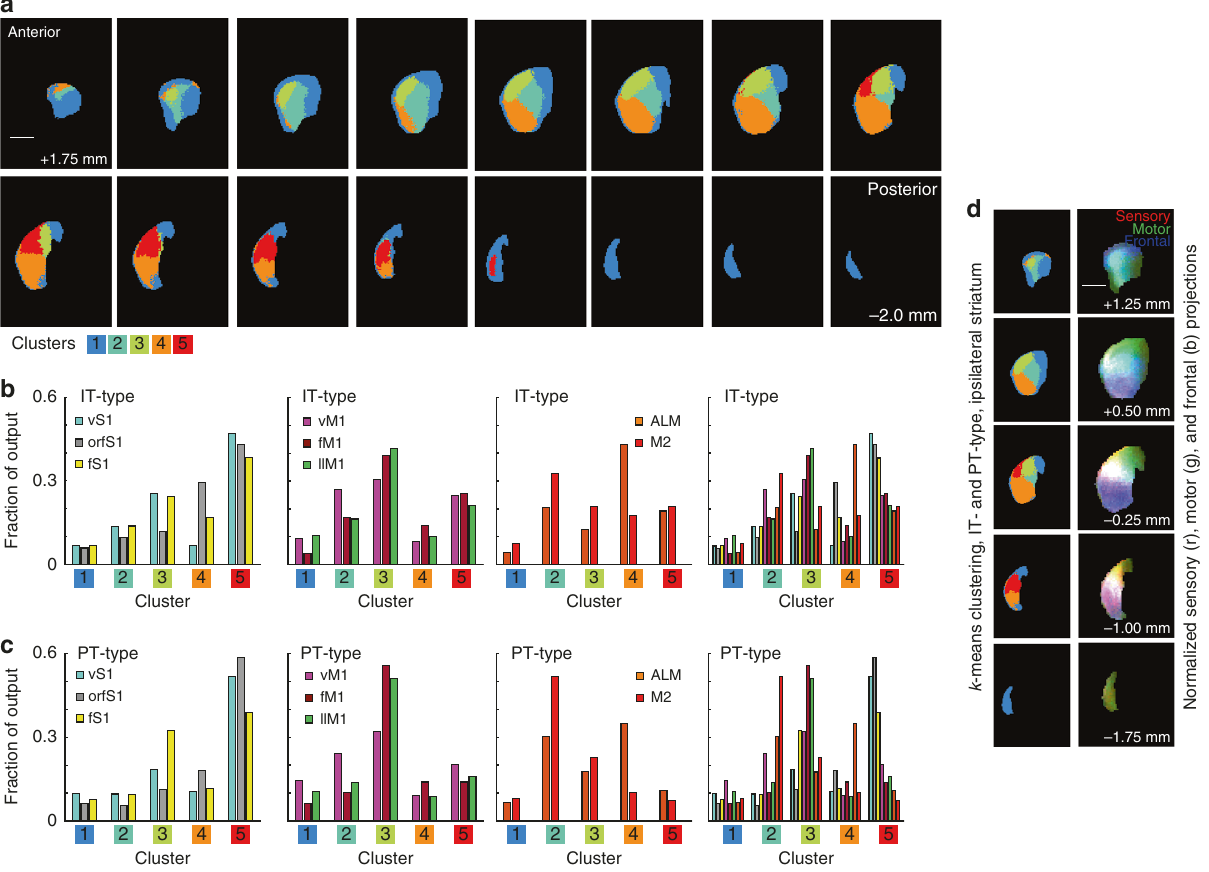
Fig. 9 Major divisions of ipsilateral striatum based on sensory and motor cortical projections. a k -means clustering of striatal pixels based on mean normalized fl uorescence intensity from each of the eight injection site clusters for both IT-type and PT-type pyramidal neurons. The striatal clusters are illustrated as fi ve colors (legend, at bottom) in evenly spaced planes every 0.25 mm from anterior (top left) to posterior (bottom right). Scale, 1 mm. b The fraction of the output from each of the eight injection site clusters to a given striatal division from IT-type projections. Graphs are divided into sensory (left), motor (center), and frontal (right), with all areas together at far right. c The fraction of the output from each of the eight injection site clusters to a given striatal division from PT-type projections, presented as in b . d A comparison of the striatal divisions based on k -means clustering (left) to the pattern of normalized sensory (red), motor (green), and frontal projections (blue), presented as an RGB image (right). Scale, 1